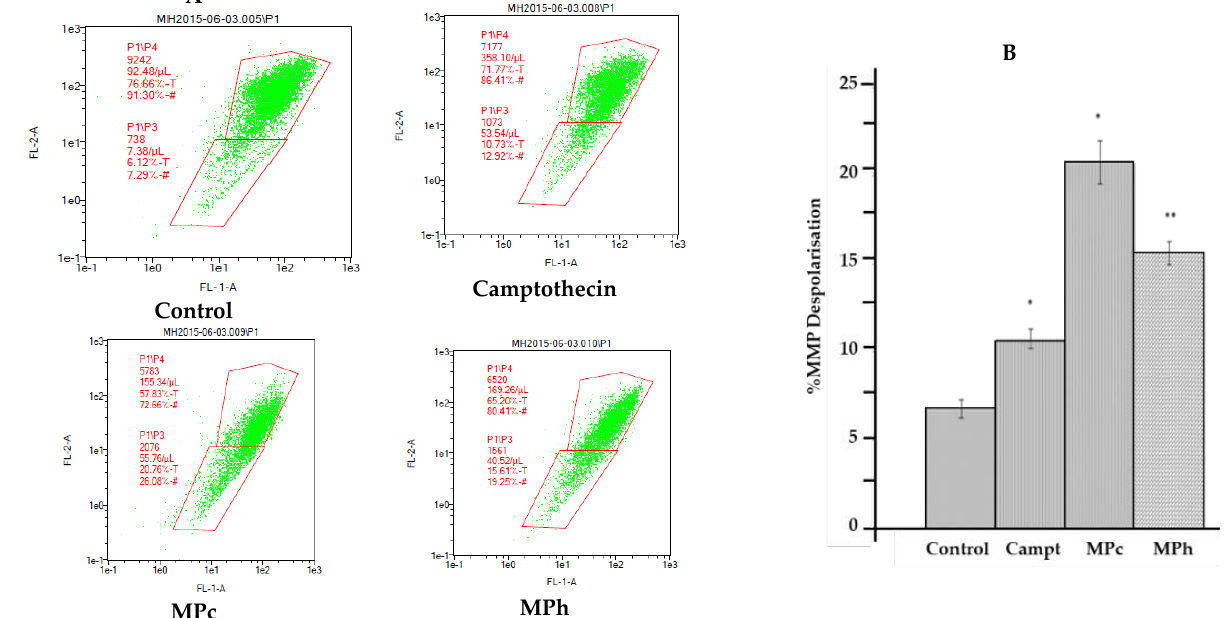
Figure 6. Depolarization of mitochondrial membrane potential (MMP) of PC3 prostate cancer cell lines was induced by the active extracts of Marantodes pumilum . PC3 cell lines were treated with the IC50 of MPc and MPh or Camptothecin (Camp) for 6 hours. ( A ) Representative MMP profiles of flow cytometry for active plant extract-treated PC3 cells. ( B ) Quantification of depolarization inten- sity. The data are means ± SEMs ( n = 3). * p < 0.05 and ** p < 0.01, against control, were determined via unpaired t -test.